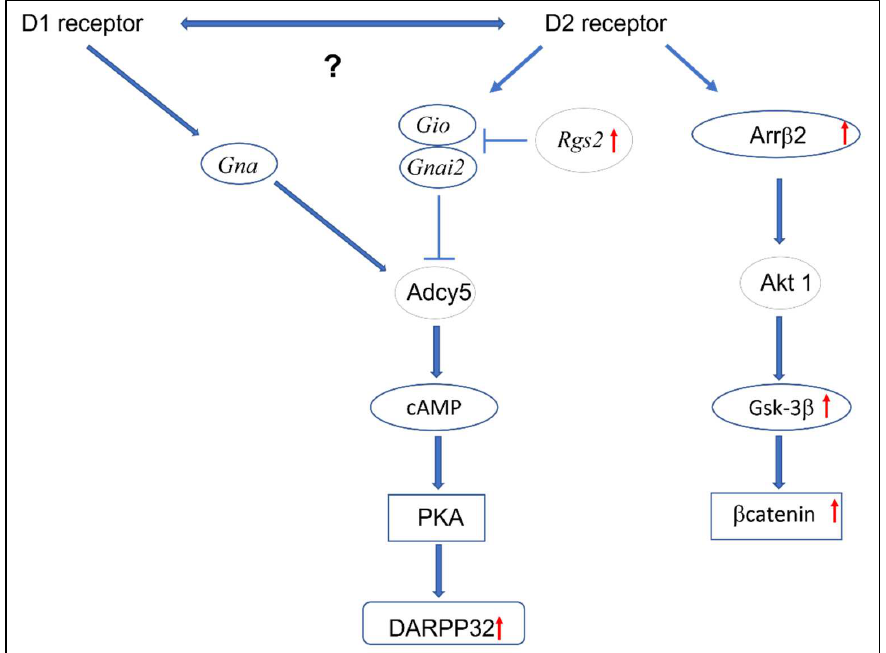
Figure 4. An illustrative diagram showing the signal transduction pathways in the PFc of WKY strain